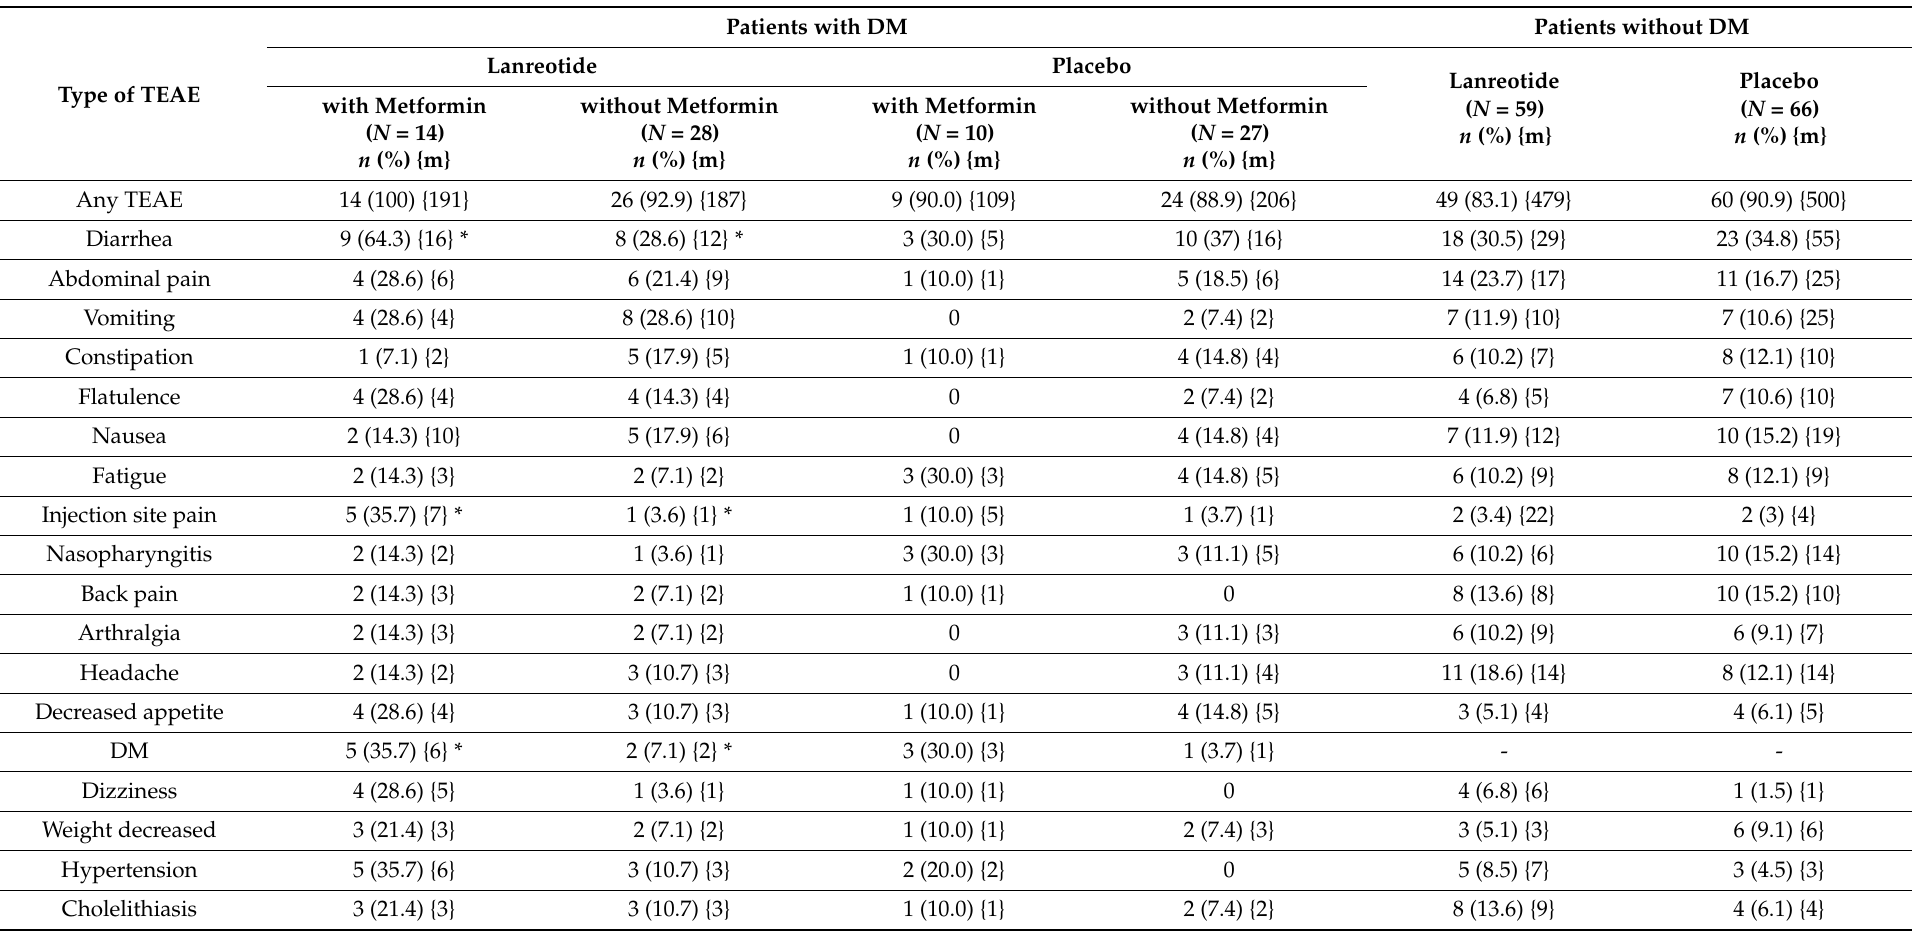
Table 4. Summary of